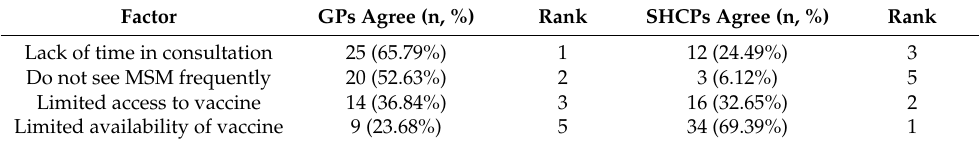
Table 4. Most frequently ranked factors preventing GPs and SHCPs vaccinating YMSM against HPV. Factor GPs Agree (n, %) Rank SHCPs Agree (n, %) Rank Lack of time in consultation 25 (65.79%) 1 12 (24.49%) 20 (52.63%)